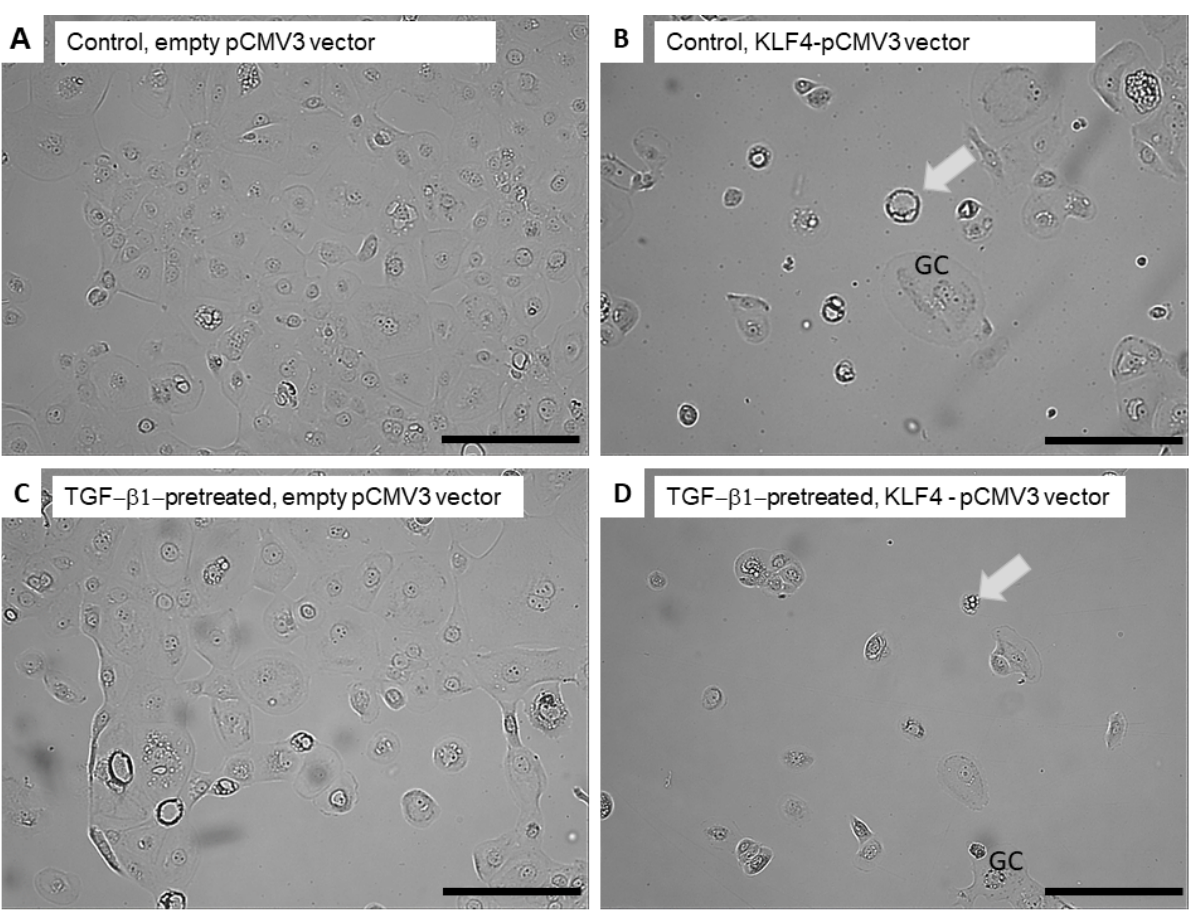
Figure 7. Morphological phase contrast images of SCC-25 cell culture plated at 3 × 10 4 cells/mL 7 days after the Cisplatin treatment. The cells transfected with empty pCMV3 vector ( A ) show epithelial proliferation with heterogenetic cell morphology both in case of TGF-beta1-pretreated ( C ) and not pretreated cells ( A ). The KLF4-transfected cells are less in number ( B , D ), especially if they were TGF-beta1-pretreated ( D ) contain vacuolized cells (arrows) and more nuclear giant cells (GC), which do not proliferate. Scaling bars: 500 µm.